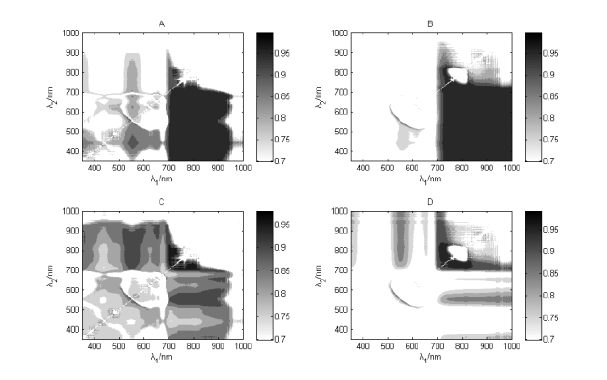
Figure 2 R 2 ’s isogram of narrow band SR, NDVI and